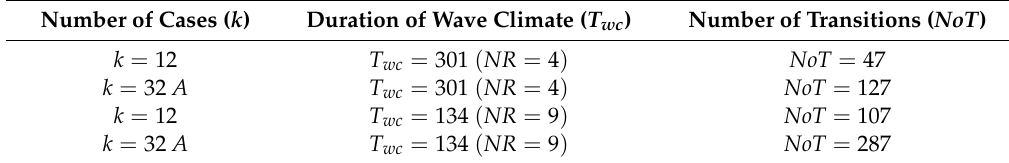
Figure 9. Initial and final profiles with the reduced wave climate of the STBM, random sequencing, k = 12 and T wc = 301 days ( a ), k = 32 A and T wc = 301 days ( b ), k = 12 and T wc = 134 days ( c ), and k = 32 A and T wc = 134 days ( d ). The black lines are the initial (dashed) and final (solid) profiles from the brute force model. The colored lines are the final profiles of each random sequence. Table 6. Number of cases, duration of wave climate, and number of transitions.